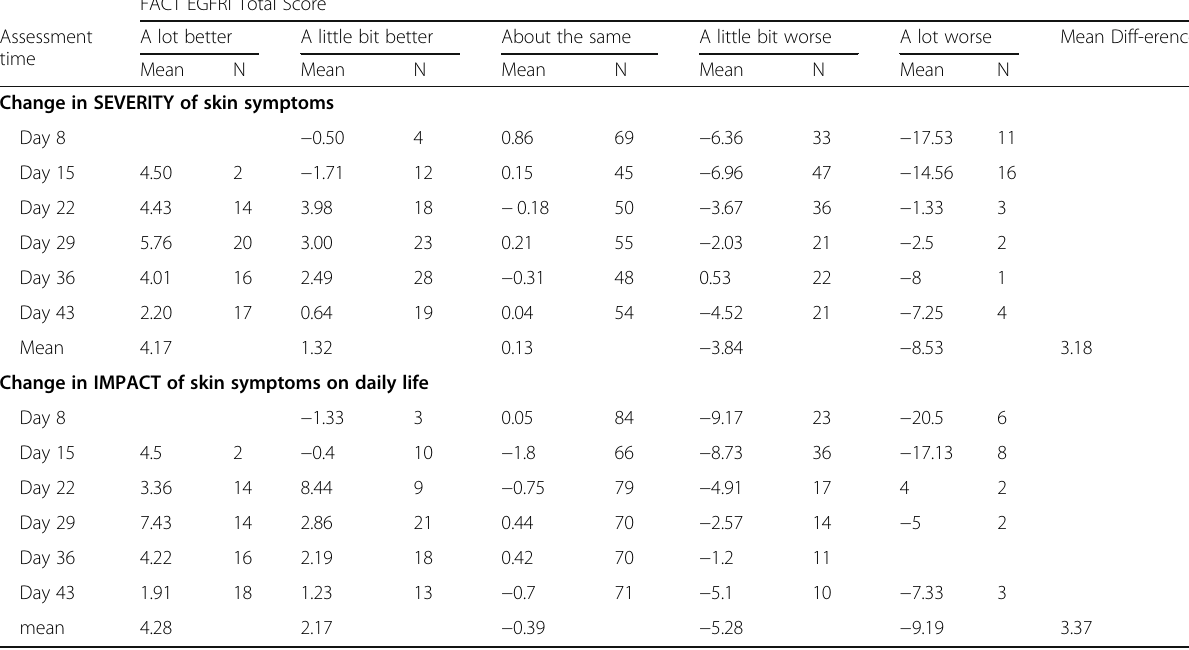
Table 3 Mean Change in FACT-EGFRI by Patient-Reported Change in Severity and Impact of Skin